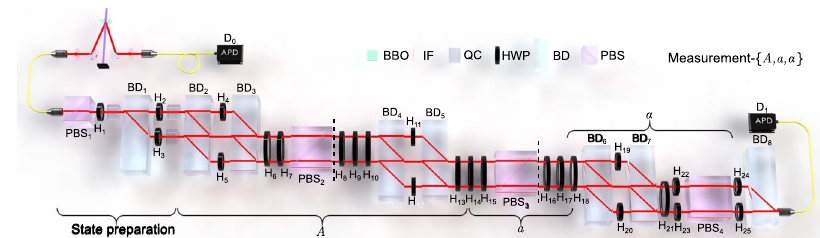
Fig. 1 Experimental set-up. The heralded single photons are created via type-I SPDC and are injected into the optical network. The fi rst polarizing beam splitter (PBS1), half-wave plates (HWP1 – 3), and beam displacer (BD1) are used to generate the pure qudit states. To prepare mixed states, quartz crystals (QCs) are inserted to destroy spatial coherence of the photons. The measurements are realized by wave plates and BDs. The photons are detected by APDs. We use the sequential measurement { A , a , α } as an example. The measurements of A , C , b , c , α , β , and γ can be realized by the set-up involving a PBS, BDs, and several wave plates, whereas the set-ups for realizing a and B can be simpli fi ed and involve only a PBS and HWPs. The set-up only corresponds to one of the eight possible paths and the input – output statistics have been obtained by repeating the experiment, with the appropriate choices of optical elements, for eight times and recording the number of photons in the detection time 2